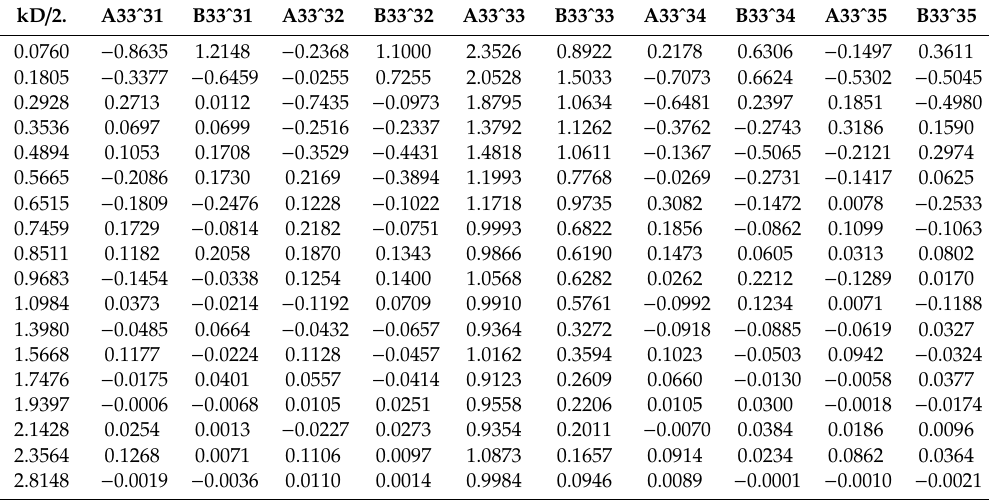
Table A2. Hydrodynamic characteristics of the 3rd floater of the array of five semi-spherical floaters. kD / 2.